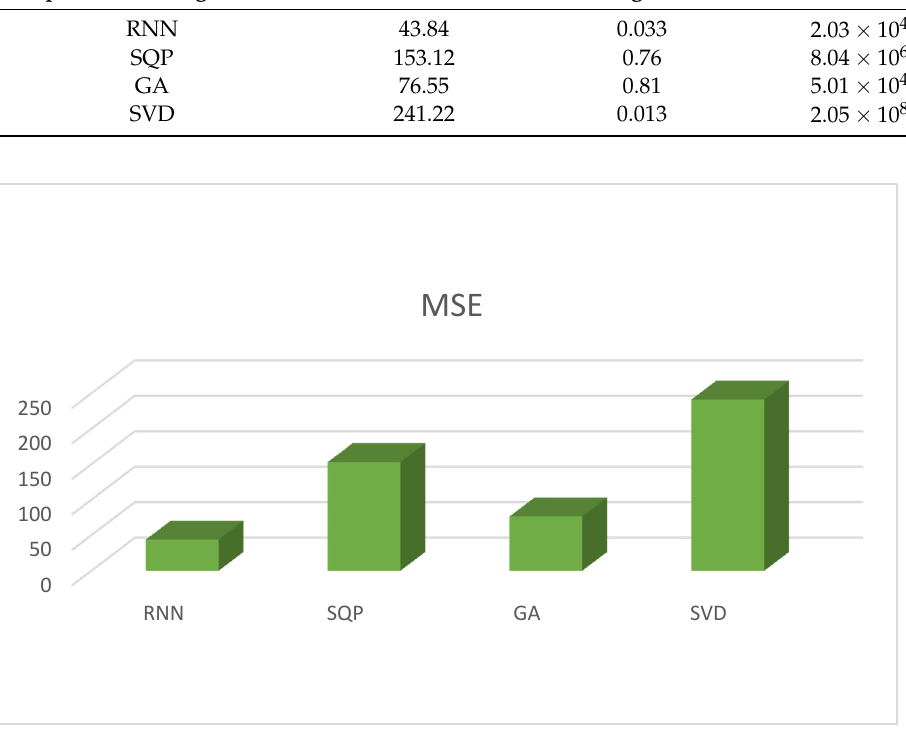
Figure 7. MSE of different optimization algorithms.